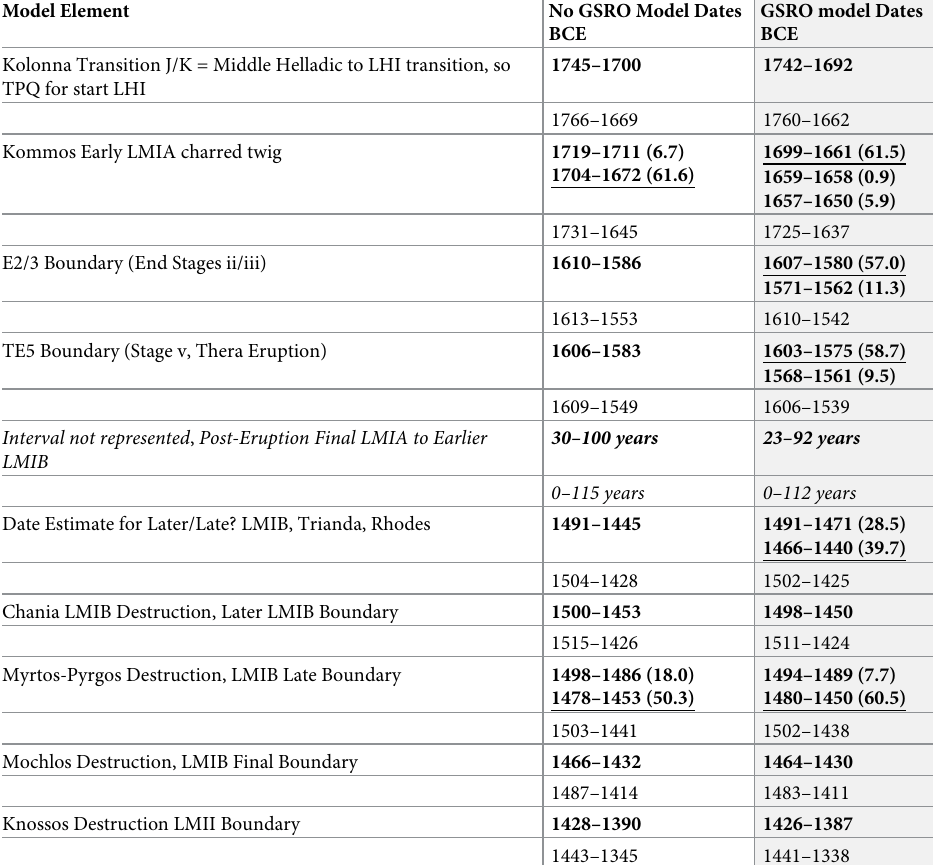
Table 4. Results (bold = 68.3% hpd, and non-bold = 95.4% hpd) for selected elements from re-runs of Model 2 without the VERA-4630 TAQ, typical examples. Compare with Table 3. Model